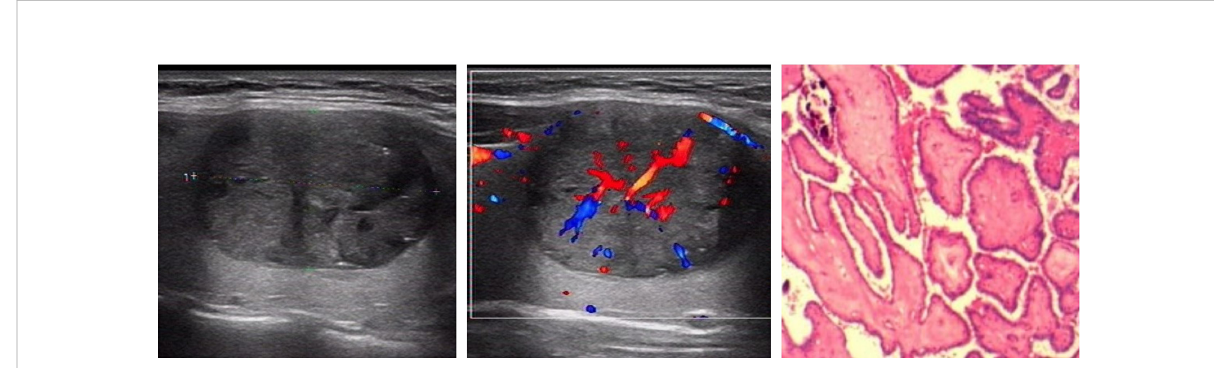
FIGURE 3 Grayscale ultrasonography shows a solid, hypoechoic nodule in the right lobe of the thyroid with wider-than-tall and smooth margin. It was classi fi ed as an ACR TI-RADS 4 lesion with moderate suspicion of cancer requiring biopsy. Color Doppler ultrasonography showed